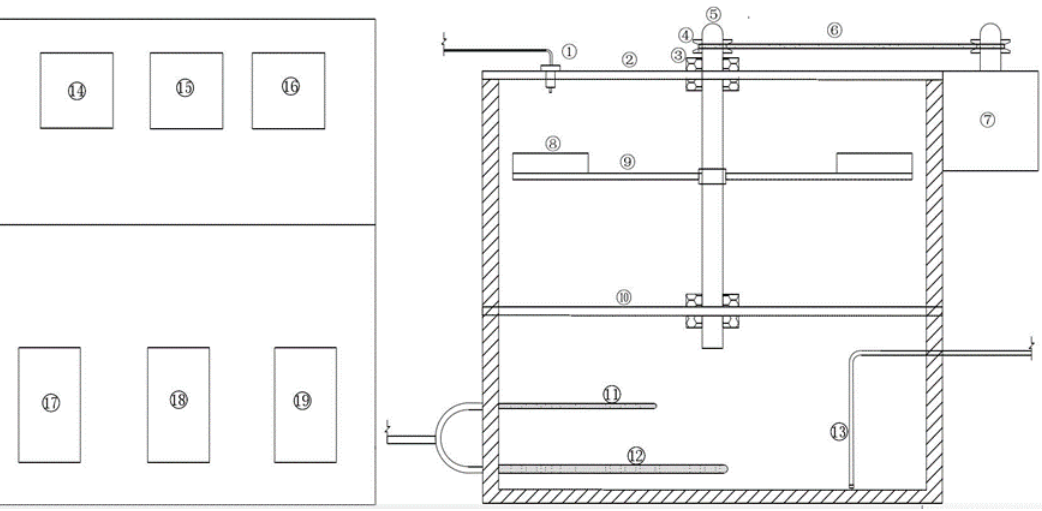
Figure 5. Pavement material dynamic water scouring tester: ( 1 ) water gun; ( 2 ) support plate; ( 3 , 10 ) bearing; ( 4 ) pulley; ( 5 ) disk fixed axis; ( 6 ) belt; ( 7 ) motor; ( 8 ) Marshall samples fixed ring; ( 9 ) disk; ( 11 ) temperature sensor; ( 12 ) U shape heating tube; ( 13 ) pump intake pipe; ( 14 ) temperature control dial; ( 15 ) scouring force control dial; ( 16 ) disk speed control dial; ( 17 – 19 ) pump and its attached equipment.